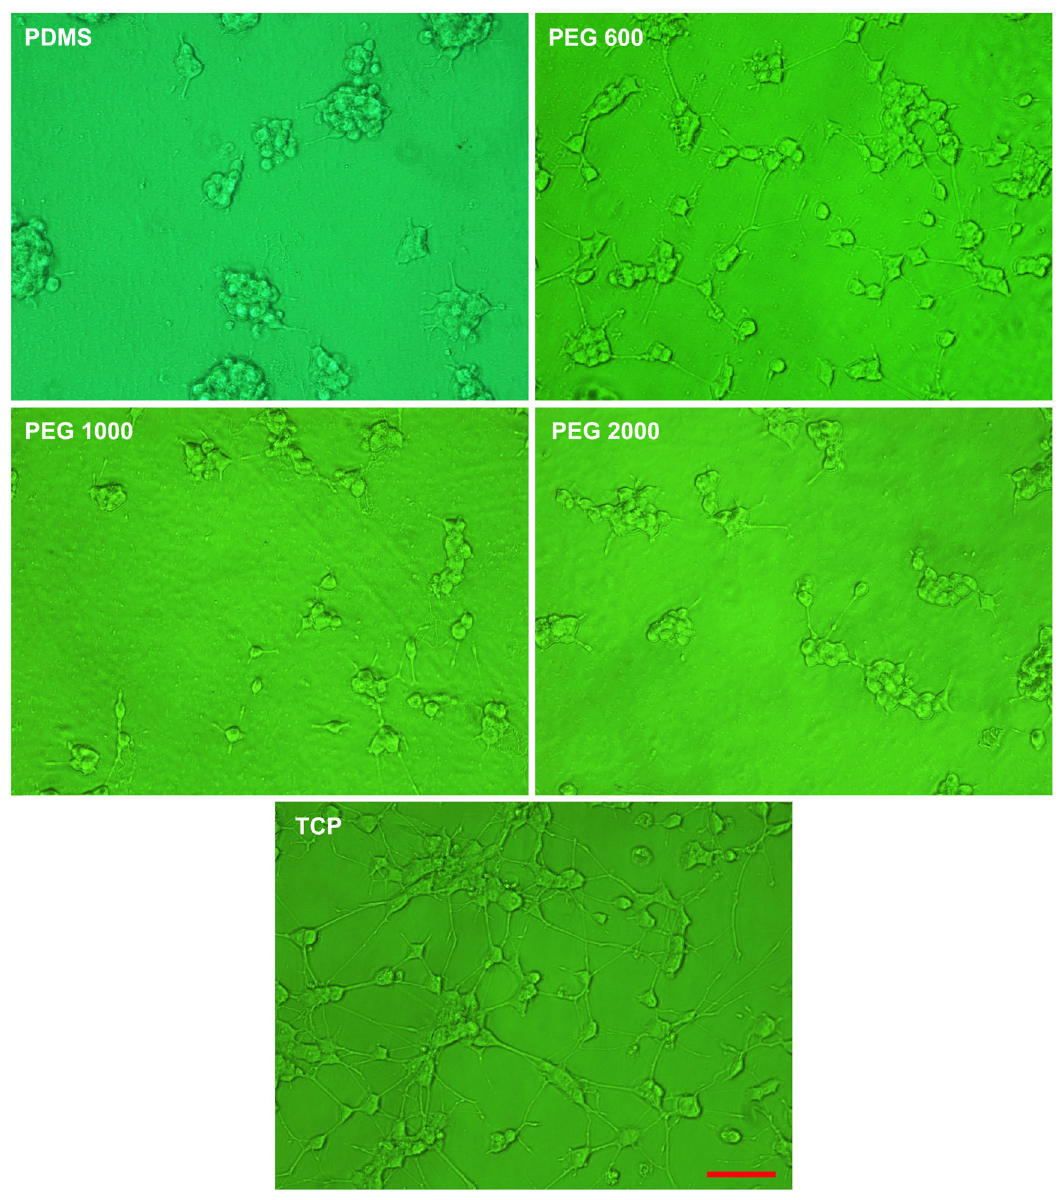
Fig. 6 Representative cell differentiation images of PC12 cells on PDMS and PDMS-PEG-PLL with PEG at various molecular weights after PBS rinses. PC12 cells on TCPs act as the positive control. Scale bar equals to 100 μ m for all the